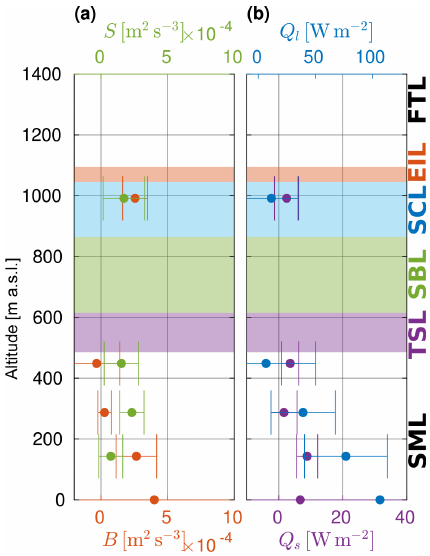
Figure 12. As in Fig. 11 but in the decoupled STBL (flight no.